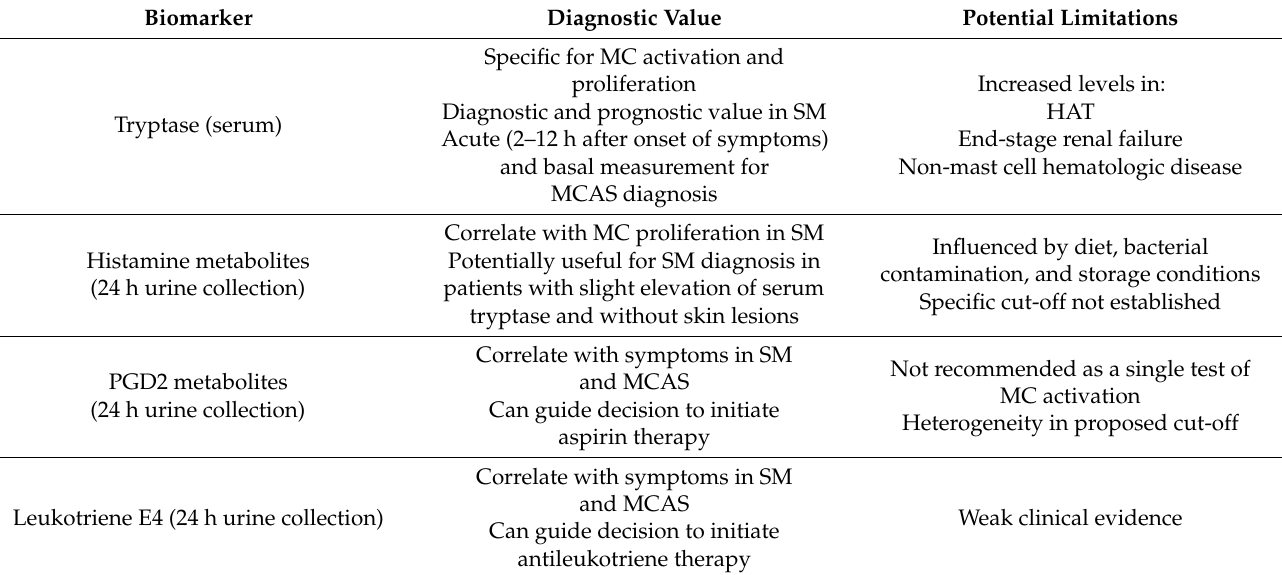
Table 3. Soluble mediators and their metabolites derived from